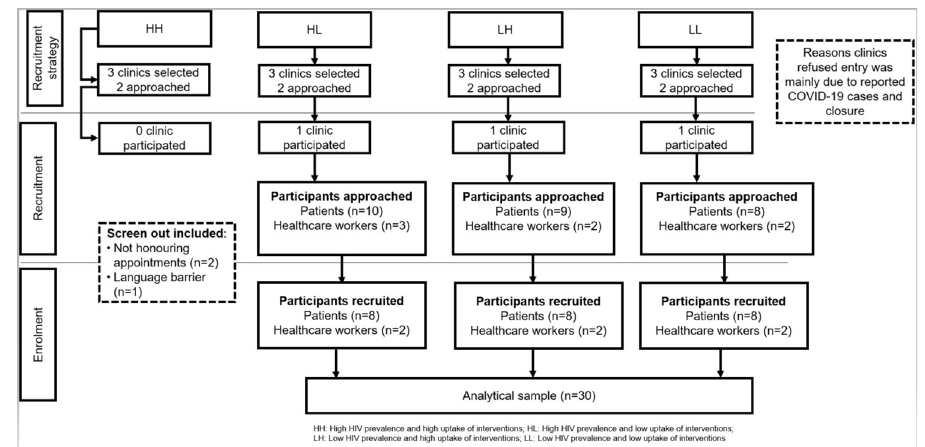
Fig 2. Flow diagram showing the recruitment strategy and enrolment of participants for the